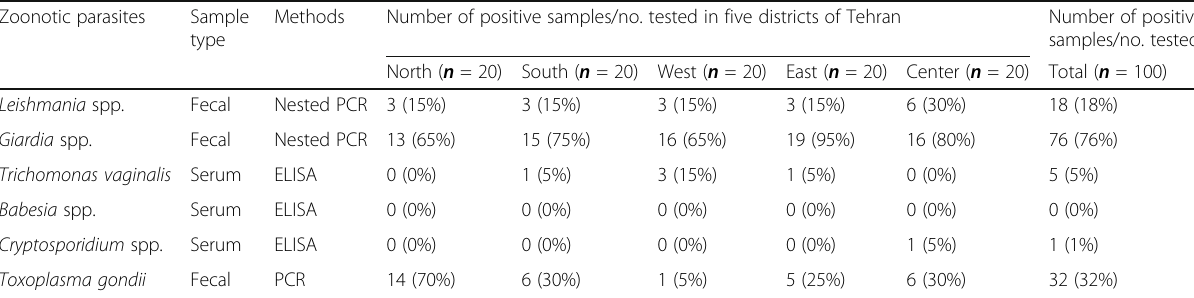
Table 2 Numbers of Rattus norvegicus and sample types positive for zoonotic parasites identified in five districts of Tehran Zoonotic parasites Sample Methods Number of positive samples/no. tested in five districts of Tehran Number of positive type